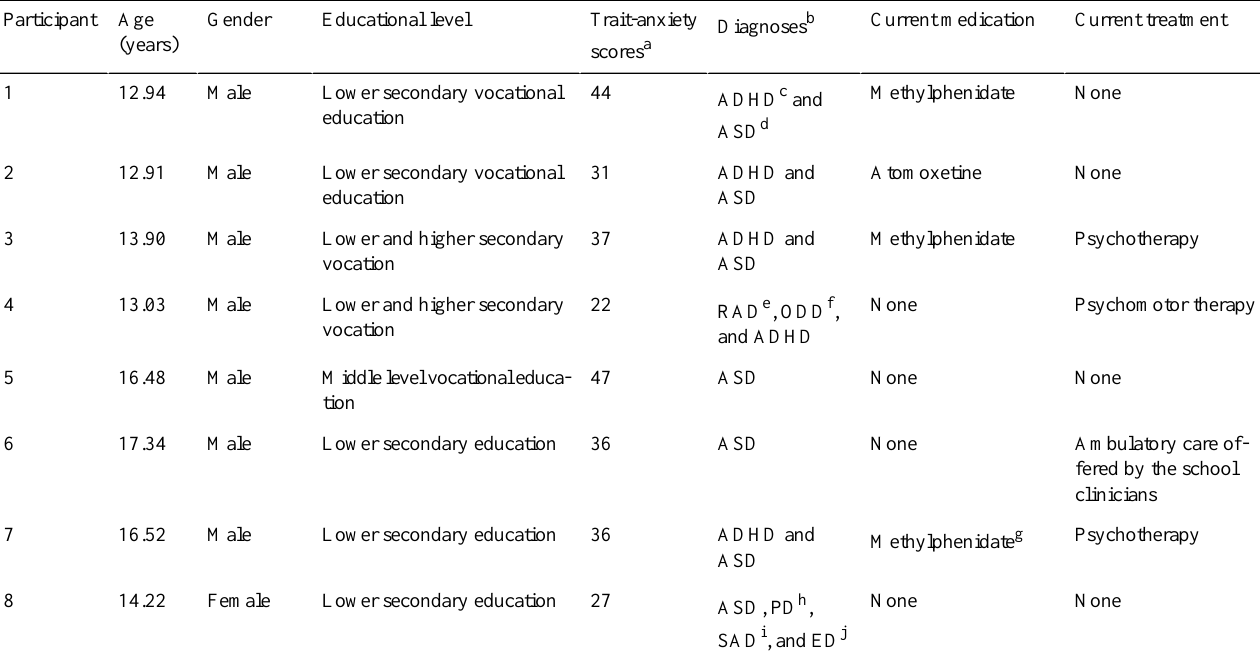
Table 1. Individualized description of participants’demographics at